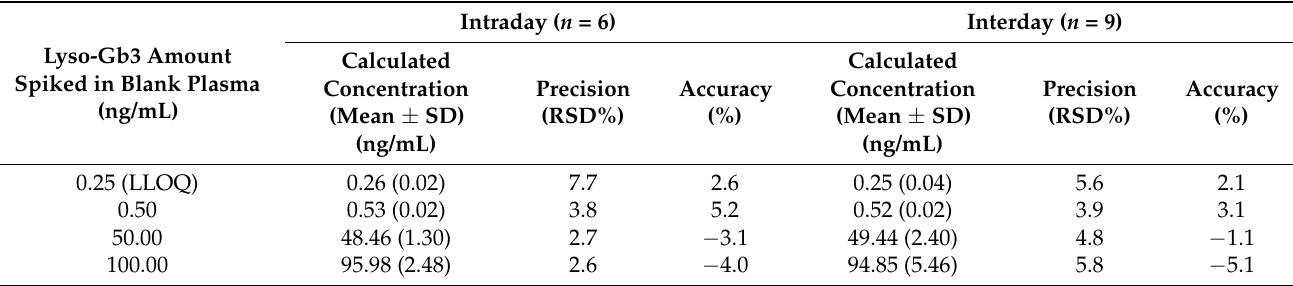
Table 1. Precision and accuracy of lyso-Gb3